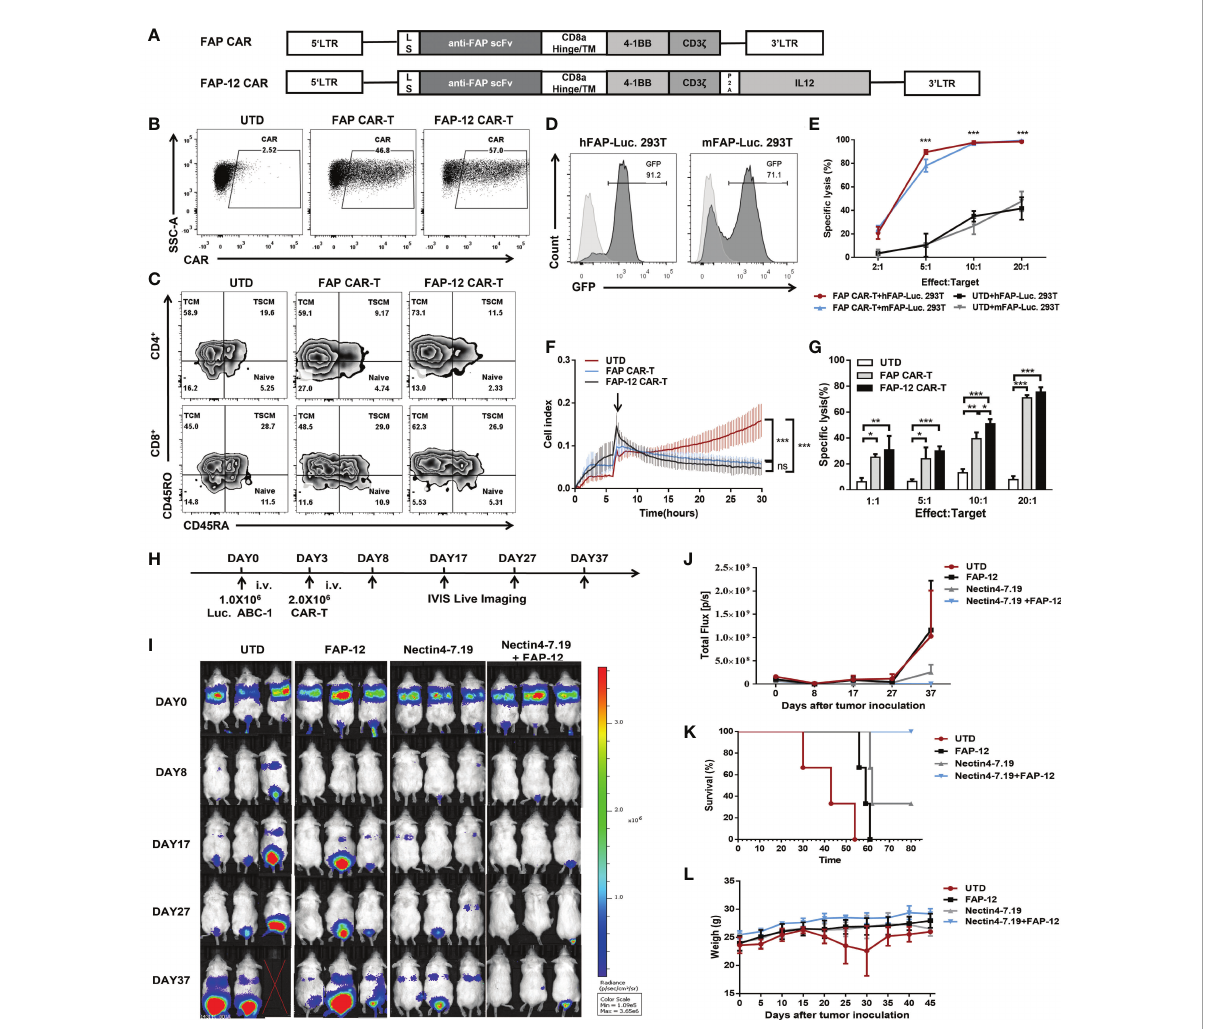
FIGURE 6 Synergistic effect of Nectin4-7.19 CAR-T with FAP-12 CAR-T therapy on metastatic lung cancer mouse model. (A) Schematic illustration of FAP CAR and FAP-12 CAR lentiviral vector. LS: leader signal. (B) CAR expression on FAP CAR-T and FAP-12 CAR-T cells. (C) Expression of CD45RA and CD45RO in CD4 + or CD8 + T subset to assess the subtypes of T cells. (D) 293T cells were transduced with lentivirus encoding the human FAP-Fire fl y-Luciferase-GFP gene or the murine FAP-Fire fl y-Luciferase-GFP gene to generate hFAP-Luc. 293T and mFAP-Luc. 293T cells, respectively. Expression of GFP was measured by fl ow cytometry. 293T cells served as negative controls. (E) Quanti fi ed data on the speci fi c lytic levels of FAP CAR-T cells against hFAP-Luc. 293T and mFAP-Luc. 293T cells were assessed by luciferase bio-luminescence technique at different Effect/Target ratios in vitro . UTD served as a negative control. (F) Cytotoxicity of FAP CAR-T and FAP-12 CAR-T cells was detected at an Effect/Target ratio of 10:1 by xCELLigence RTCA label-free technology. (G) Speci fi c lysis of FAP CAR-T and FAP-12 CAR-T cells against hFAP- Luc. 293T was detected by luciferase bio-luminescence technique at different Effect/Target ratios in vitro . (H) NSG mice were inoculated with 1.0 × 10 6 Luc. ABC-1 cells i.v. on Day 0 and received an administration of 2 × 10 6 FAP-12 CAR-T cells, 2 × 10 6 Nectin4-7.19 CAR-T cells, or an admixture of 1 × 10 6 Nectin4-7.19 CAR-T cells and 1 × 10 6 FAP-12 CAR-T cells on Day 3 ( N = 3 mice per group). A total of 2.0 × 10 6 UTD served as a negative control. (I) Tumor xenografts were monitored via bioluminescence imaging. Representative bioluminescence images of three independent experiments in each group of mice were shown. (J) Bioluminescence kinetics of the tumor growth in the model. (K) Kaplan – Meier survival curve. p -values of log-rank tests were as follows: p = 0.0246 (Nectin4-7.19+FAP-12 vs . UTD); p = 0.0246 (Nectin4-7.19+FAP-12 vs . FAP-12); p = 0.1161 (Nectin4-7.19+FAP-12 vs . Nectin4-7.19), N = 3. (L) Body weight of mice since the tumor inoculation. Data represent the mean ± SD; * p < 0.05, ** p < 0.01, *** p < 0.001, t